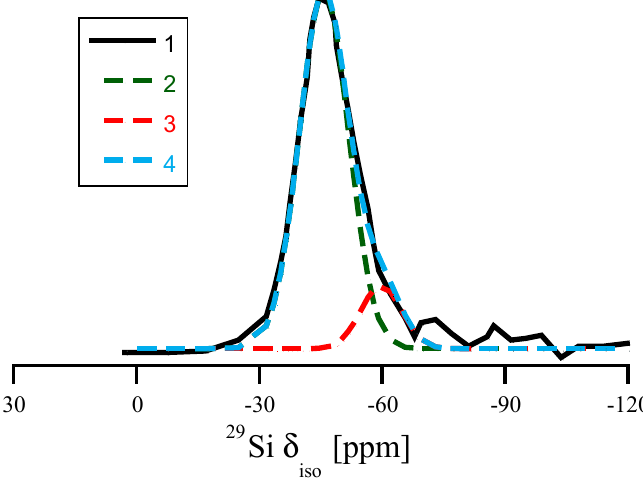
Figure 7. Replotting the data of 29 Si NMR of amorphous Si 3 N 4 according to the results of Carduner et al. in [49]. (1) the full line refers to the experimental 29 Si NMR data. (2) and (3) are two Gaussian distributions (centered at − 46 ppm and at − 60 ppm) used for decomposing the asymmetric experimental curve. (4) is the sum of (2) and (3). The ratio of areas under Gaussians 2 and 3 is approximately 7:1.